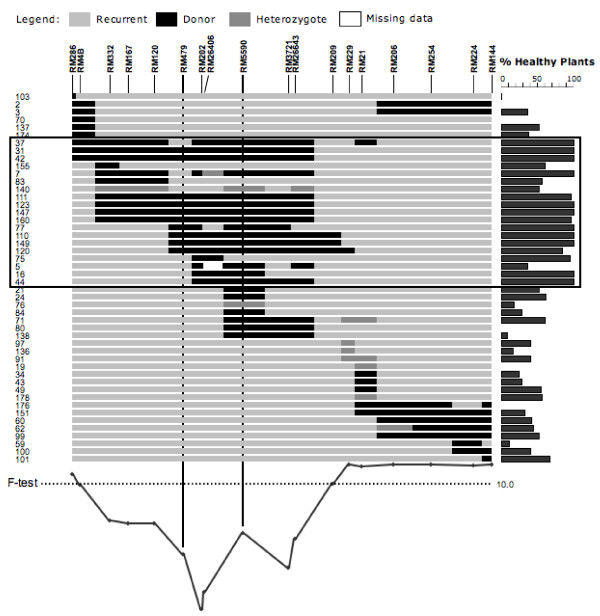
Major QTL for O. glaberrima Acc. MG12 resistance to the Rice Stripe Necrosis Virus (RSNV), located on rice chromosome 11 between SSR markers RM479 and RM5590 (F = 70.63, P ~ 0.0). On the right, solid grey bars indicate the value of percentage of healthy plants for each line. The resistant lines (% of healthy plants > 85) are located within the black frame. The most probable location of the resistance QTL is given by the intersection of the black frame and the positions of the markers RM479 and RM5590, which define a common introgressed region between the resistant lines.